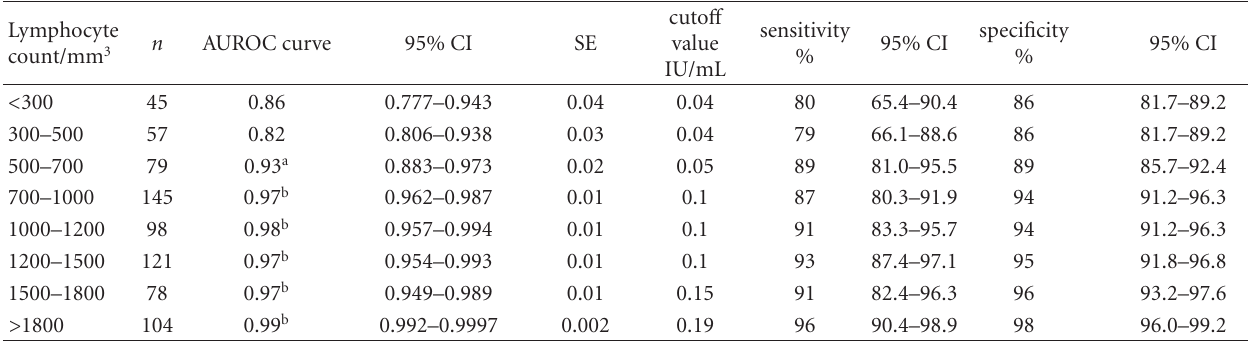
Table 3: Analysis of area under the receiver operating characteristic curves for lymphocyte-stratified patients